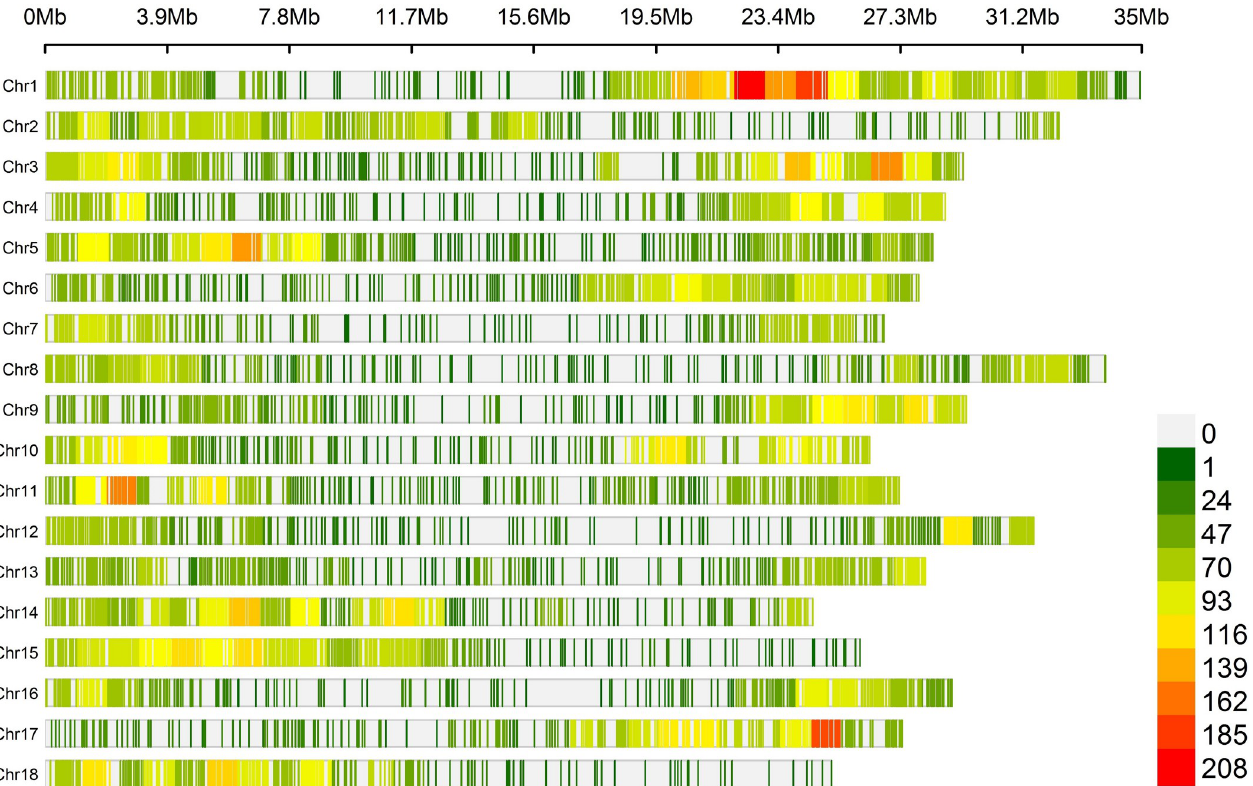
Fig 2. SNP density plot across the 18 chromosomes of cassava representing the number of SNPs within a 1-Mb window size. The horizontal axis shows the chromosome length (Mb), while the different colors depict SNP density.